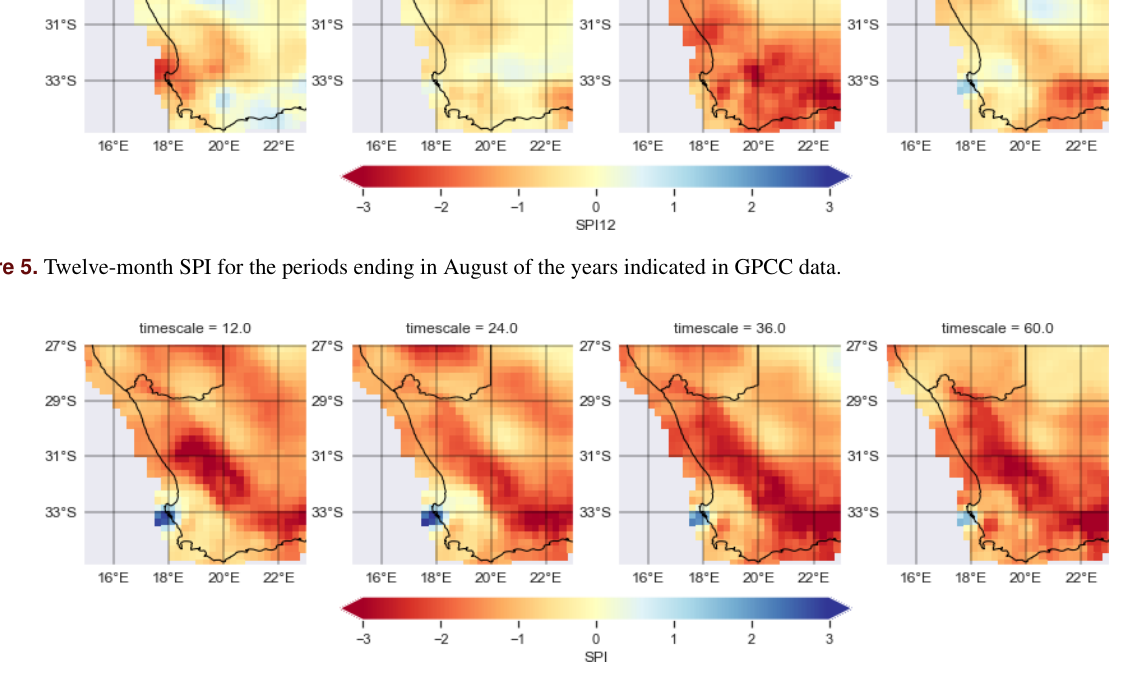
Figure 6. GPCC SPI maps for December 2019 for the timescales indicated (in